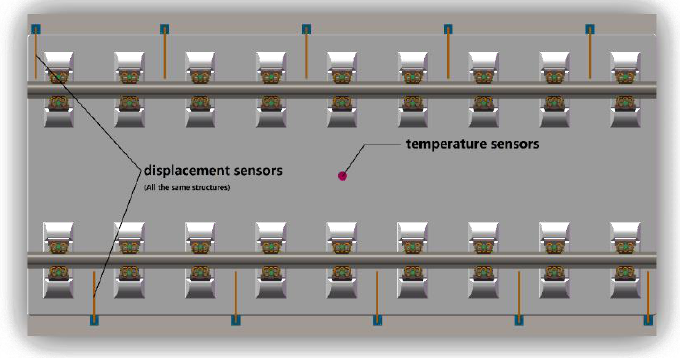
Figure 10. The schematic diagram of the sensors’ positions.